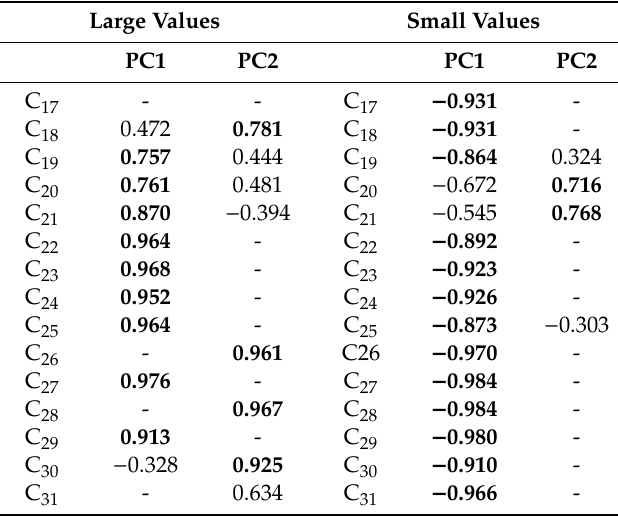
Table A1. Factors of principal components